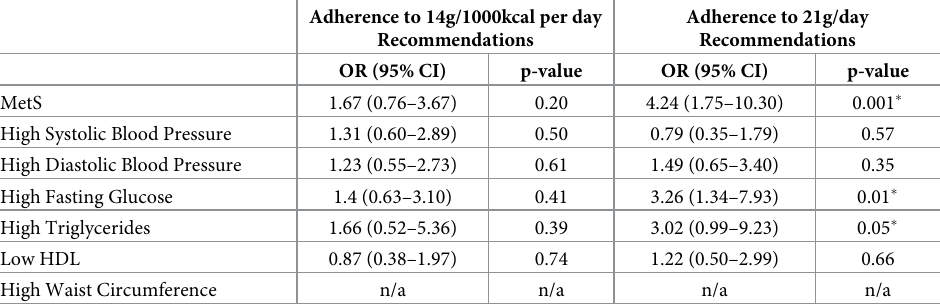
Table 3. Associations of MetS and its components in those not adherent to fiber recommendations compared to those adherent to fiber